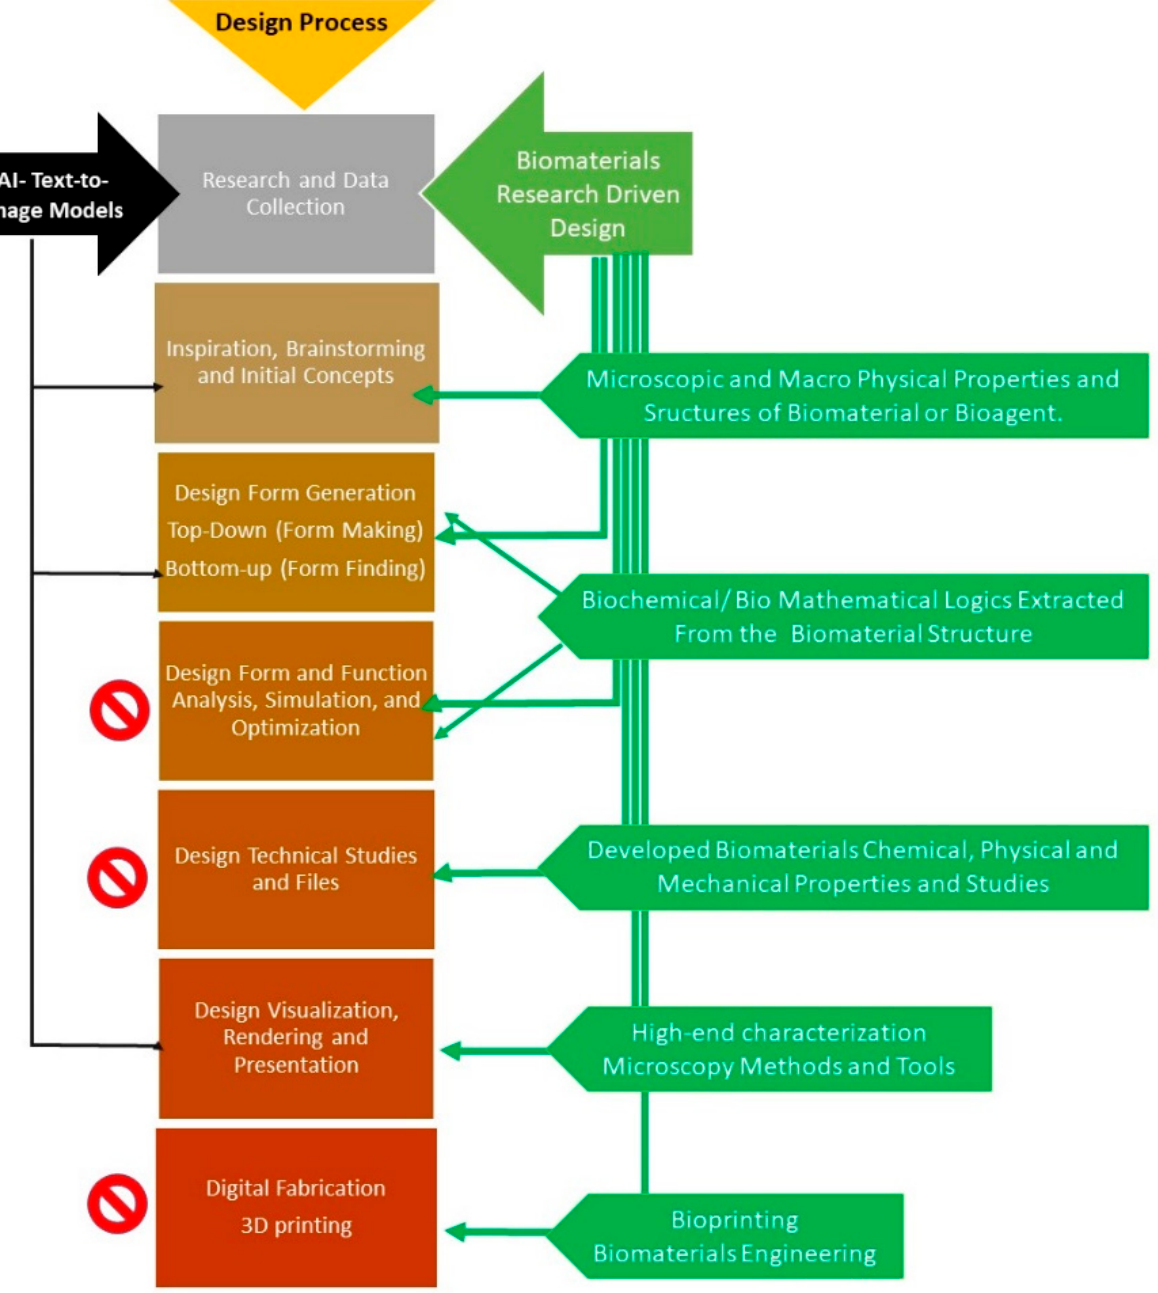
Figure 7. The role of AI text-to-image models in the biomaterials research-driven design process. Thus, the authors have designed design criteria for the AI-aided biomaterials research- driven design process and presented them in the Table 3